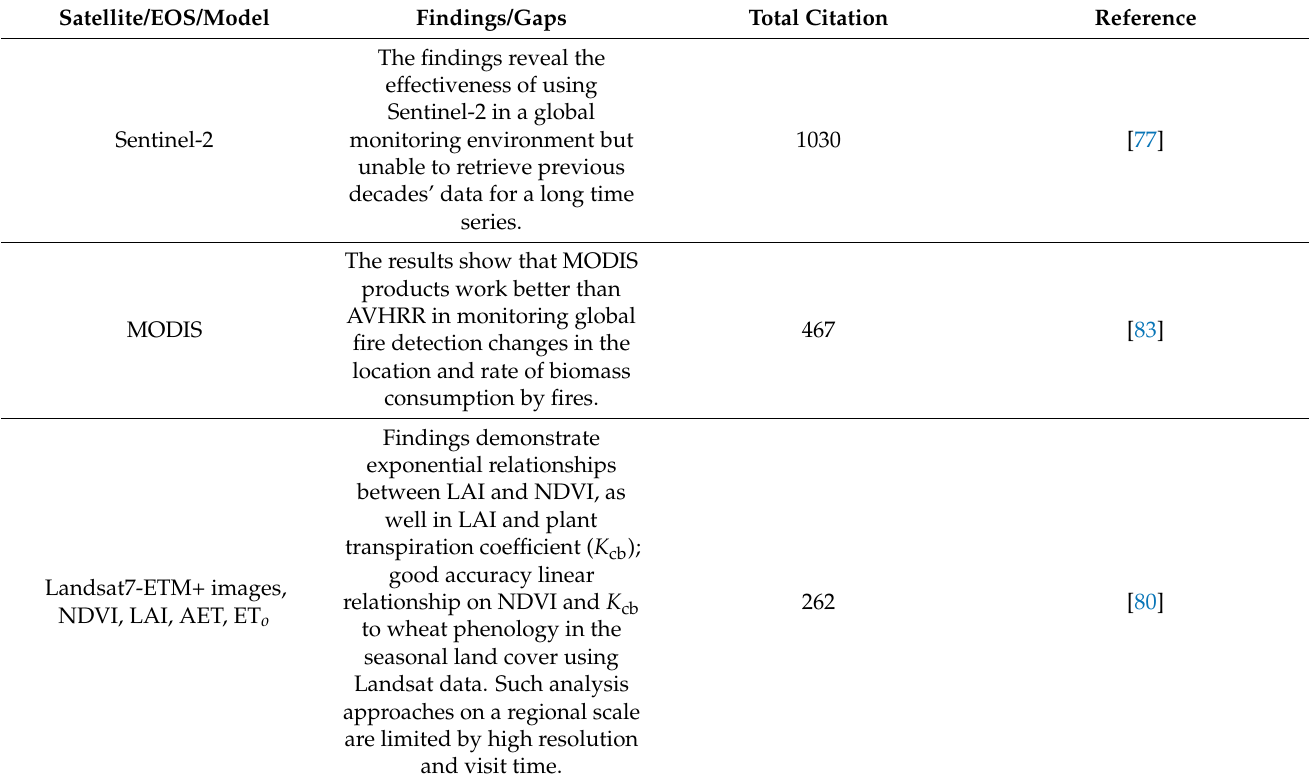
Table 4. Top 15 globally cited articles on EOS and PM studies from